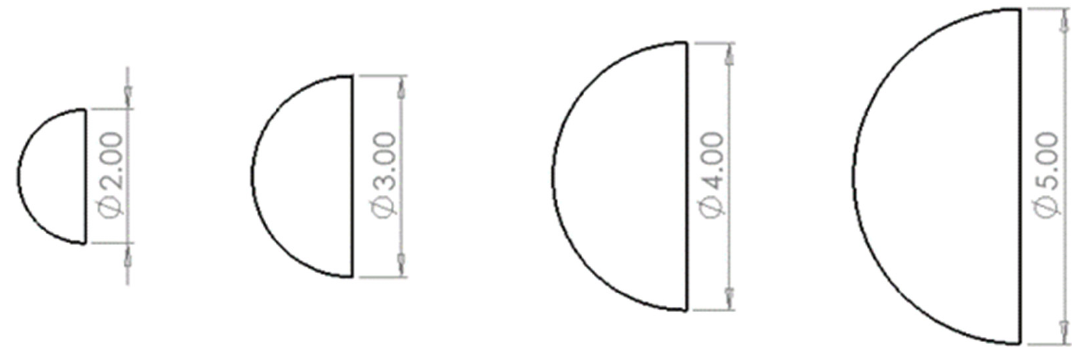
Figure 13. Varying diameter for HCD channels–cross-section view (dimensions in mm).